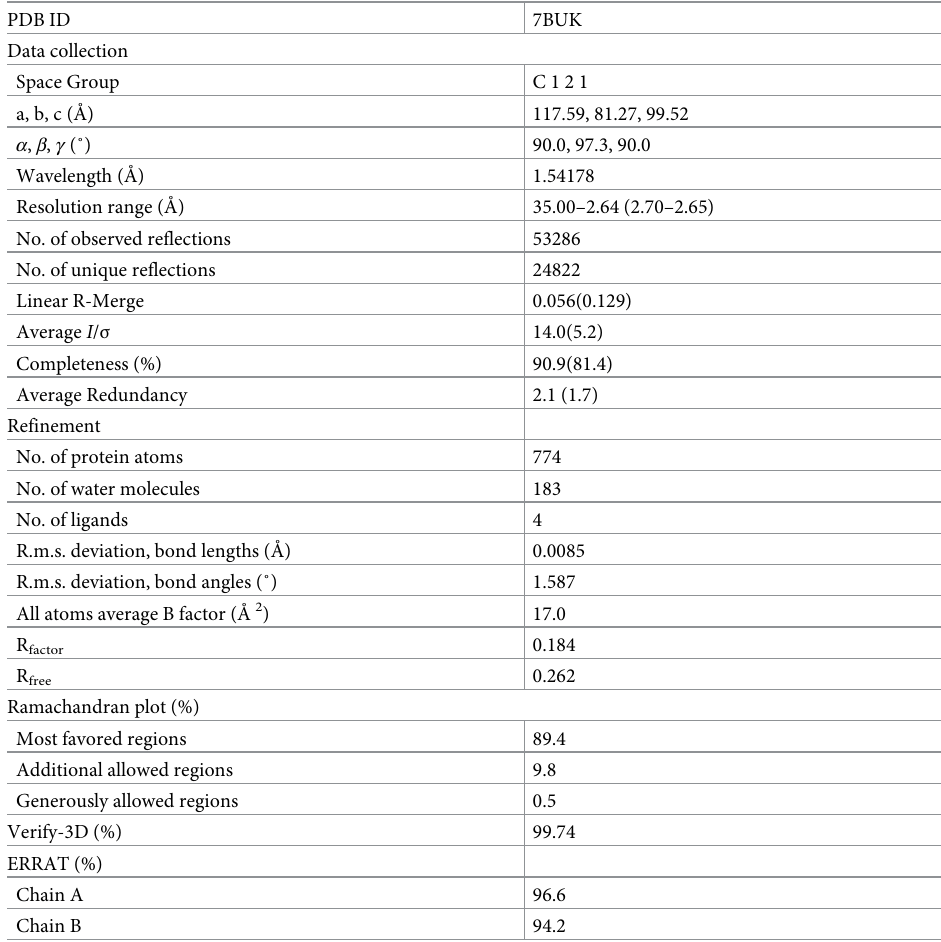
Table 1. Data statistic of X-ray diffraction